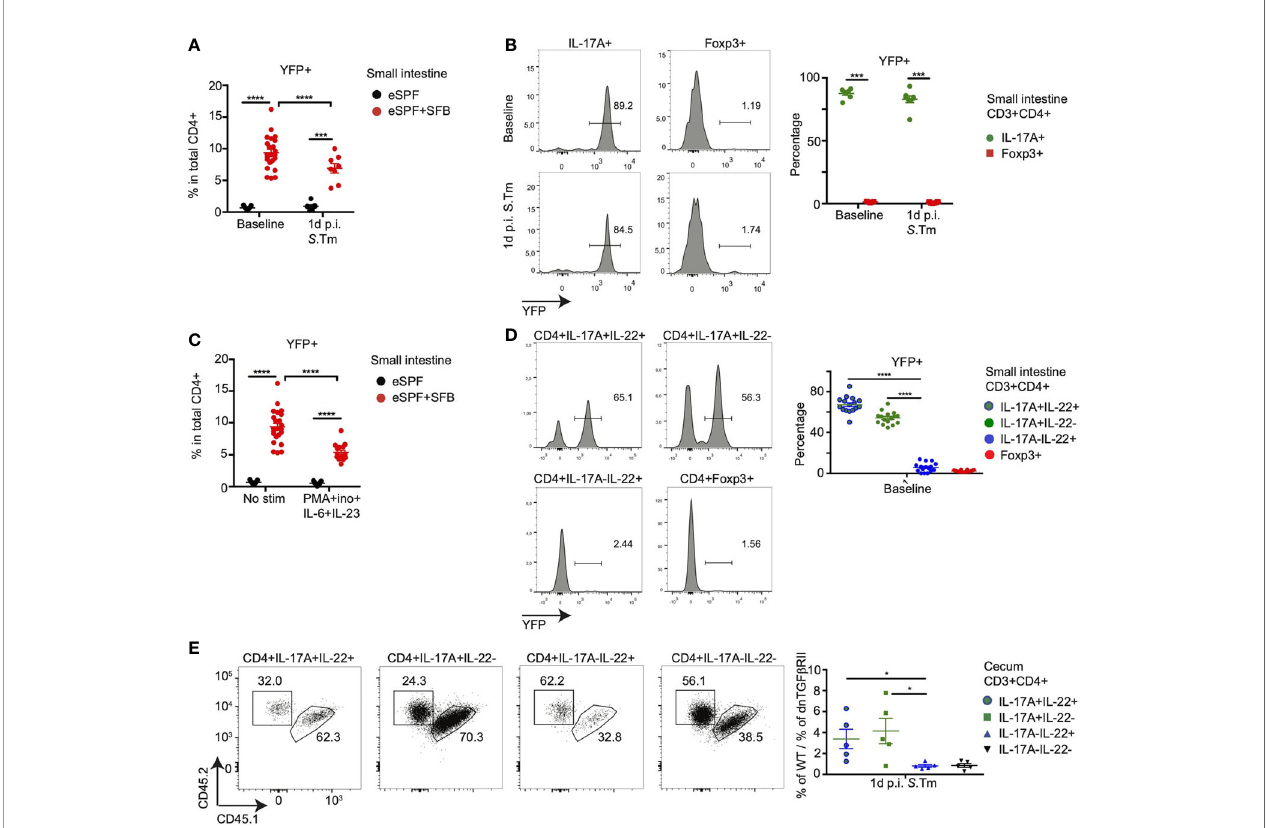
FIGURE 7 | SFB-induced Th-22 cells development is independent of IL-17 secretion. (A, B) CD3+CD4+ T cells from small intestinal LPL from eSPF and eSPF+SFB colonized IL-17A CRE R26 YFP IL-17A GFP IL-22 BFP Foxp3 RFP (Fate reporter) mice were analyzed for YFP expression during baseline and 1d post S . tm . infection without ex vivo restimulation. YFP expression in total CD3+CD4+ cells (A) . YFP expression in IL-17A+ and Foxp3+ cells from eSPF+SFB colonized mice (B) and in left, representative FACS plots and right, frequencies of YFP+ cells in CD4 T cells expressing IL-17A and Foxp3. (C, D) CD3+CD4+ T cells from small intestinal LPL from eSPF and eSPF+SFB colonized Fate reporter mice were stimulated ex vivo under stated condition and analyzed for YFP expression during baseline. YFP expression in total CD3+CD4+ cells (C) . YFP expression in IL-17A+ and/or IL-22+ cells and Foxp3+ cells from eSPF+SFB colonized mice (D) and in left, representative FACS plots and right, frequencies of YFP+ cells in CD4 T cells expressing IL-17A and/or IL-22 and Foxp3 without any ex vivo restimulation. (E) CD3+CD4+ T cells from cecal LPL after 1d S . tm. infection from eSPF+SFB colonized Rag2 -/- mice, that received CD4+ T cells from congenically labeled WT and CD4dnTGF b RII mice (1:1), were analyzed for expression of congenic markers in IL-17A+ and/or IL-22+ and Foxp3+ cells after restimulation. Left, representative FACS plots and right, frequencies of YFP+ cells in CD4 T cells expressing IL-17A and/or IL-22 and Foxp3. Data represent n = 5 – 17 mice/group as mean ± SEM from at least two independent experiments. P-values indicated represent an unpaired Student ’ s t test *p < 0,05; ***p < 0,001; ****p < 0,0001. See also Supplementary Figure S7